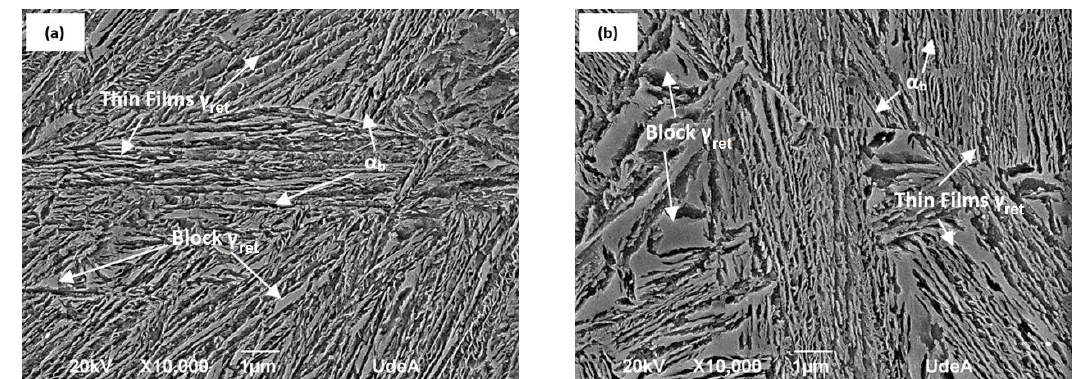
Figure 6. Secondary electron SEM images of the microstructure of the alloy with 0.76% of C, after austenitization at 830 °C/15 min., and treated isothermally at ( a ) 250 °C/480 min., and ( b ) 300 °C/240 min. Where γ ret is austenite and α b bainitic ferrite.